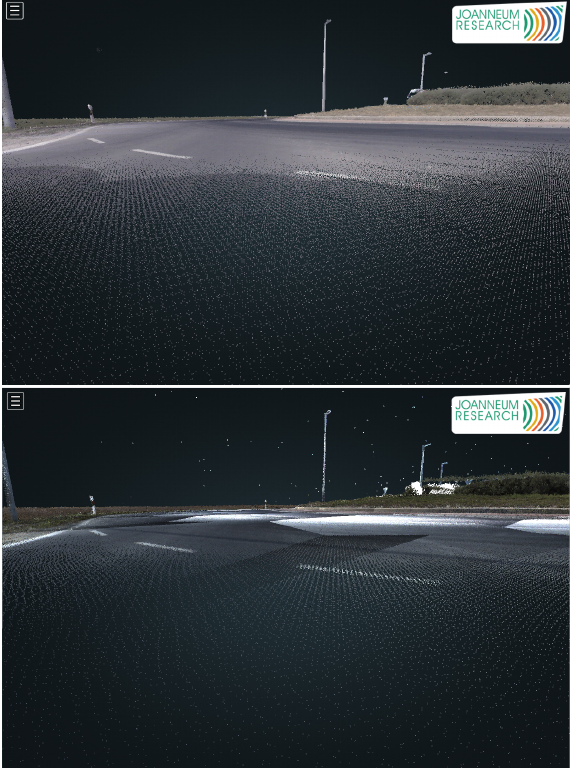
Figure 9. Comparison between the Z+F 9012 ( top ) and the Riegl VQ-450 ( bottom ) while scanning ground level of an exit arm in a roundabout.The reduced point density of the Riegl compared to the Z+F scanner is clearly visible. Both systems are dual profiler